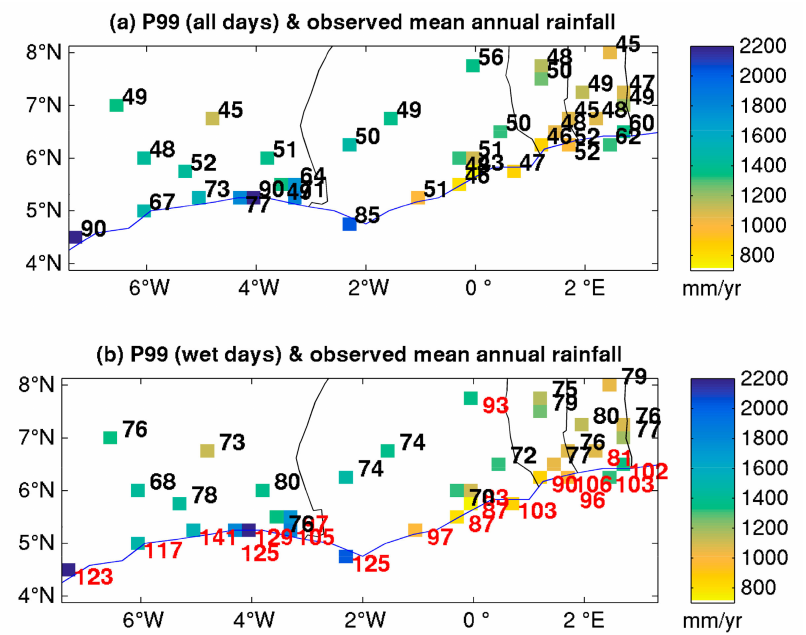
Figure 2. Spatial distribution of observed mean annual rainfall (color squares) and values of the 99th percentile (P99) of daily rainfall (values in mm). ( a ) P99 computed using all days (wet and dry); ( b ) P99 computed using wet days only, with values above 80 mm in